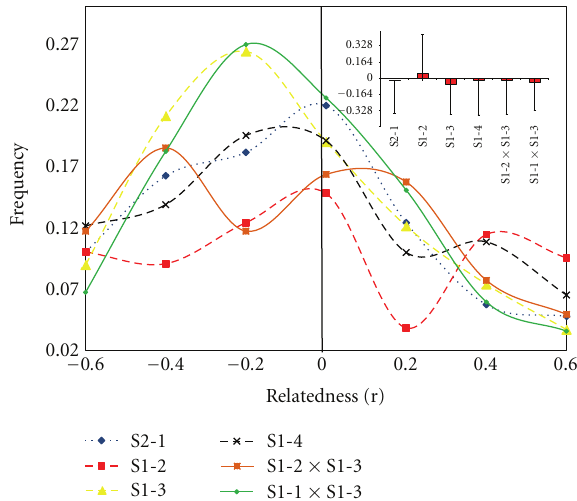
Figure 2: Relatedness coe ffi cient distributions between individual pairs from stocks of L. vannamei shrimps used for culture in Cuba, calculated according to [18], with 4 microsattellite loci: M-1 [10], Pvan 0040, Pvan 1758, and Pvan 1815 [11]. Rigth inside: mean values and standard deviation of relatedness coe ffi cients for all stocks. P value for statistical comparison is